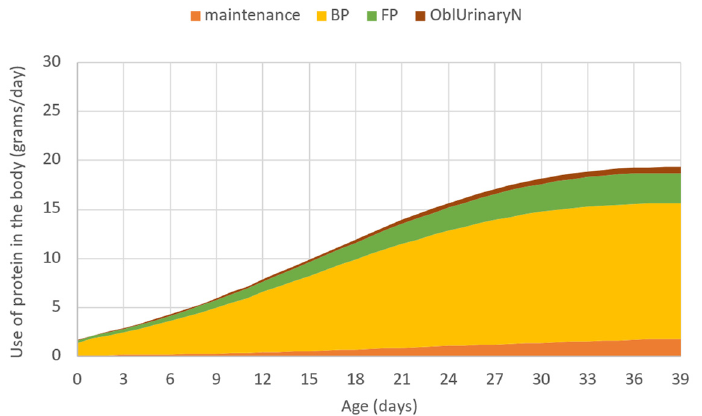
Figure 3. The use of protein in the body in grams per day simulated by the model, where: mainte- nance—protein used for maintenance; BP—empty feather-free body protein deposition; FP—feather protein deposition; OblUrinaryN—obligatory excretion related to protein deposition.